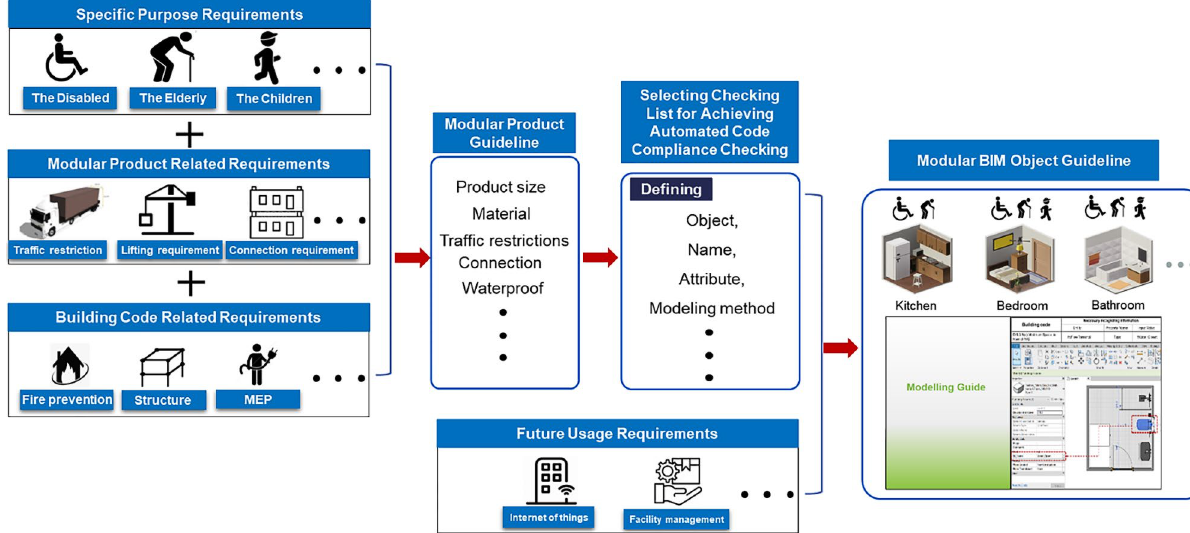
Figure 2. Process of modular BIM object guideline development